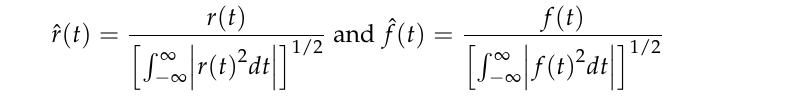
Figure 13. ( a ) Configuration of the backscattered signal measurement setup, and ( b ) picture of the experimental environment.